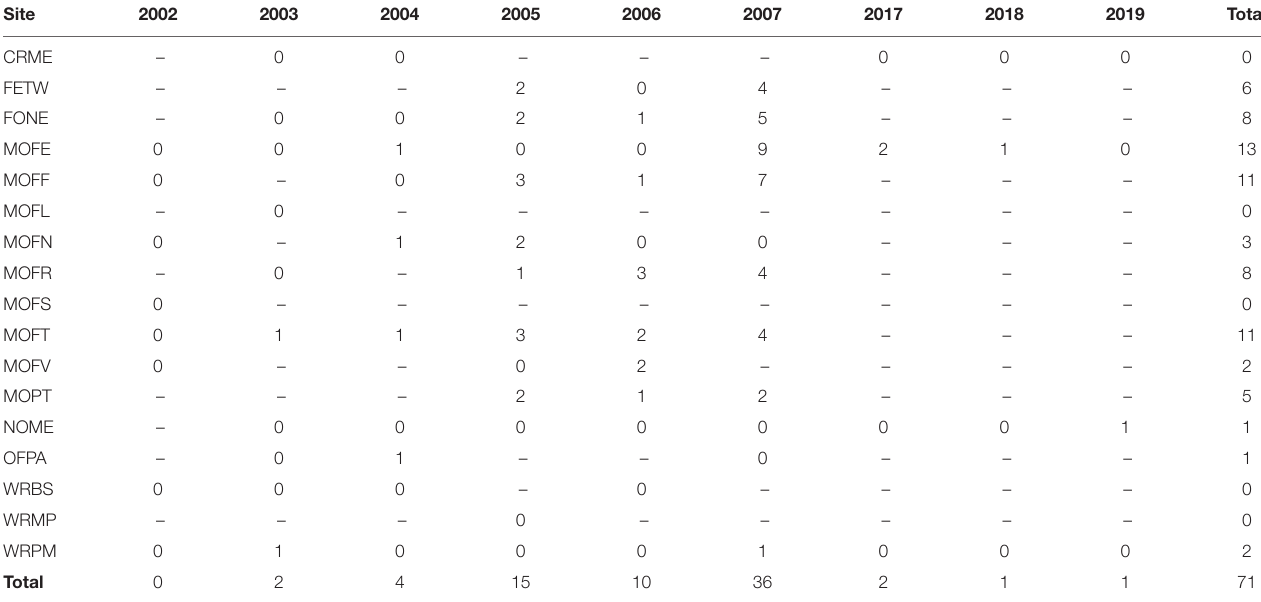
TABLE 8 | Juvenile cowbird captures by site and year.